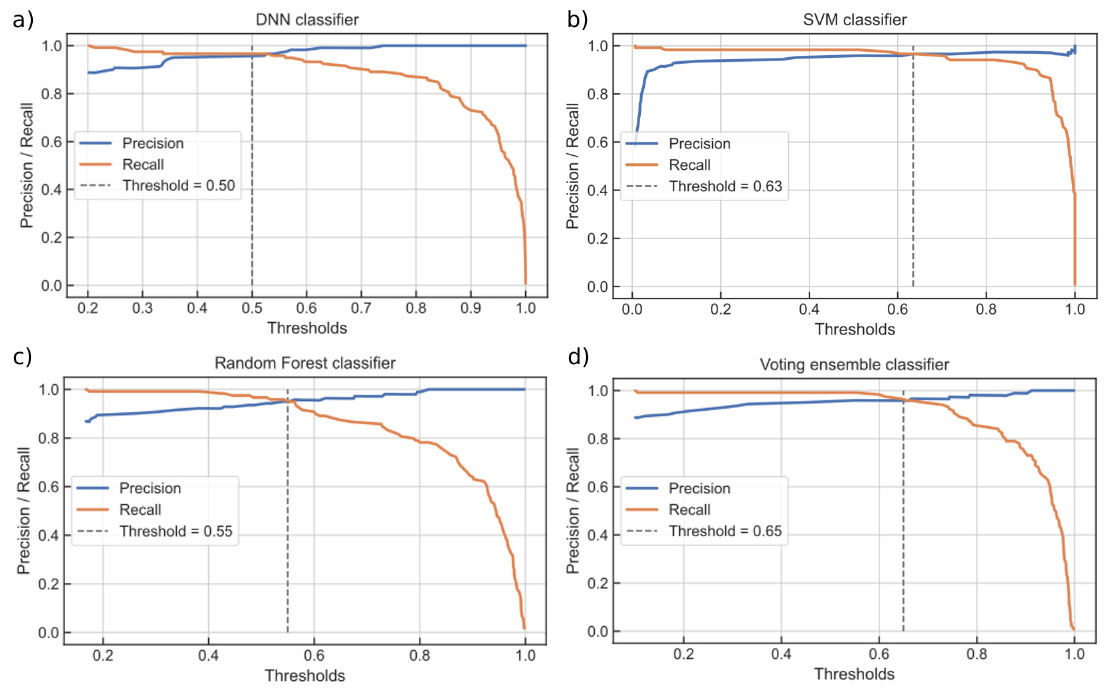
Figure 10. Precision/recall trade-off curves for each of the classifiers: ( a ) DNN classifier, ( b ) SVM classifier, ( c ) RF classifier and ( d ) VE classifier.